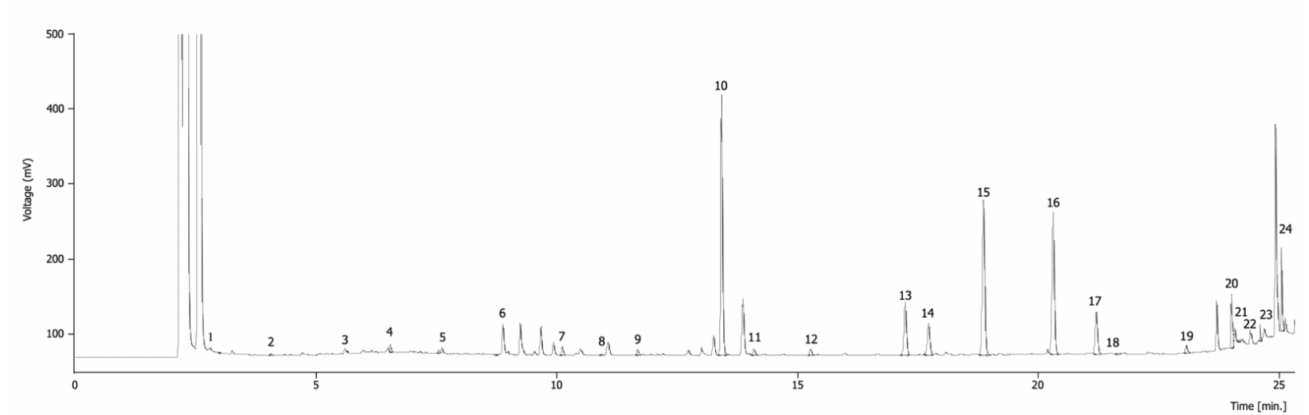
Figure 1. Fatty acids chromatogram of Cynara cardunculus L. var. altilis blades (sample B4, PGS